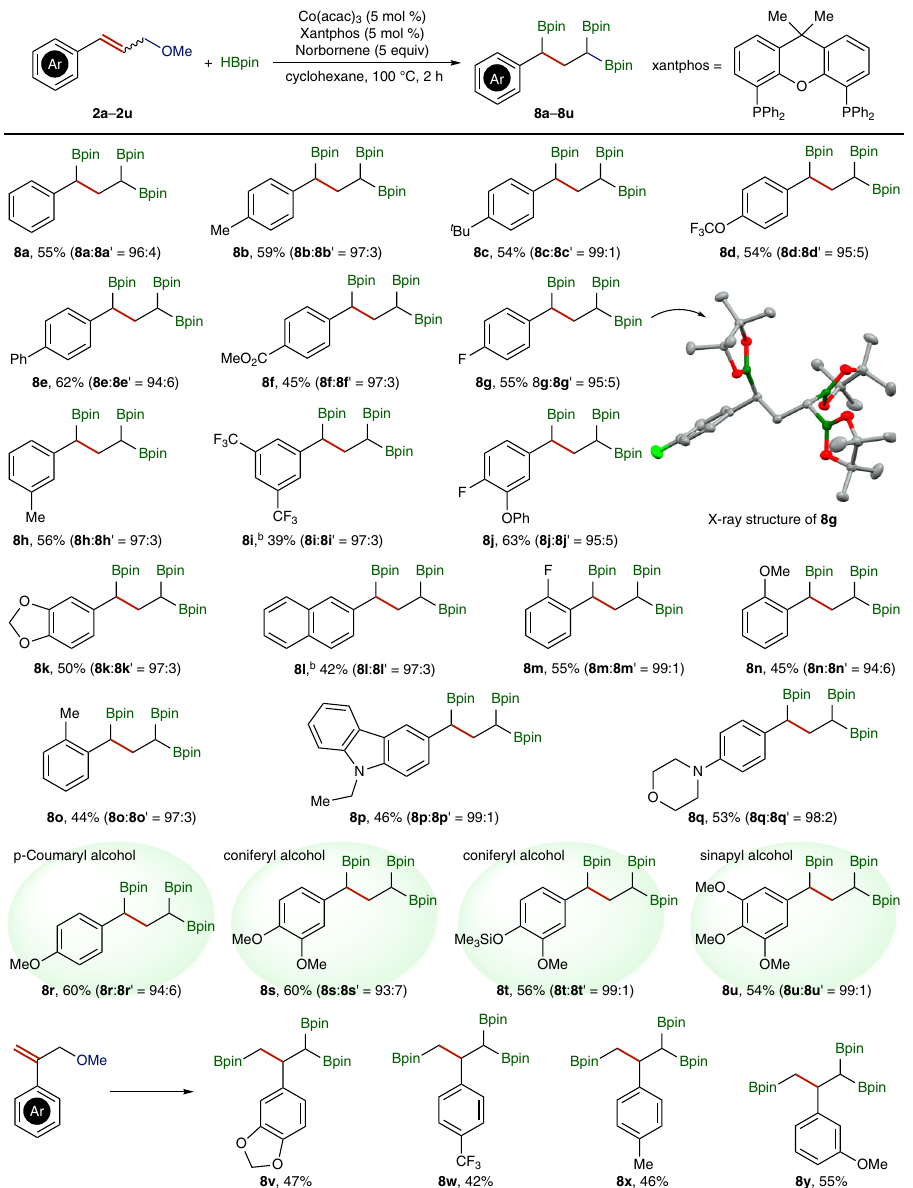
Fig. 2 Substrate scope of allylic ethers for this cobalt-catalyzed triborylation reaction. Conditions: a Co(acac) 3 (15.0 μ mol), xantphos (15.0 μ mol), allylic methyl ether (0.300 mmol), HBpin (1.80 mmol), nbe (1.50 mmol), cyclohexane (10 mL), 100 °C, 2 h, isolated yields, regioselectivity ( 8 : 8 ′ ) in parentheses; b Solvent cyclohexane/THF (1 :